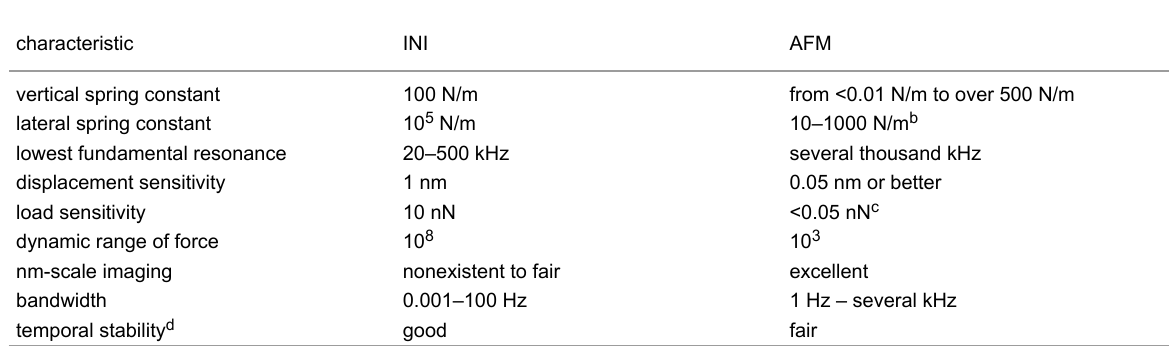
Table 1: Comparison between instrumented nanoindentation (INI) and atomic force microscopy (AFM). a